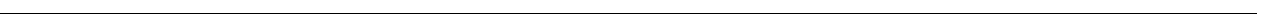
Fig. 6 PI3K inhibition enhances cap-dependent translation inhibition in KRAS de fi cient cells. a Schematic of cap-dependent translation reporter construct. 5 ′ -LTR 5 ′ long terminal repeat of MSCV virus with promoter activity. In transduced cells, mCherry expression correlates with cap-dependent translation and GFP expression correlates with cap-independent translation initiated via an internal ribosomal entry site (IRES). b FACS plots of GFP and mCherry fl uorescence in KRAS intact and de fi cient (KO) cells. KRAS de fi cient cells exhibited a greater decrease in mCherry (relative to GFP) expression when treated for 24 h with GDC-0941 (2 μ M) or the mTORC1/2 inhibitor AZD8055 (100 nM) than intact cells. Triangle gates were drawn along the midline diagonal of the FACS plots of DMSO-treated cells and maintained in plots of drug treatment. Numbers denote percentages of cells within gate and is inversely related to cap-dependent translation of reporter. c FACS plots of GFP and mCherry fl uorescence in KRAS de fi cient cells transduced with myr-AKT1 or myr-AKT1 (K179M) . Wild-type AKT1 expression decreased the effect of GDC-0941 on cap-dependent translation compared to its kinase-dead